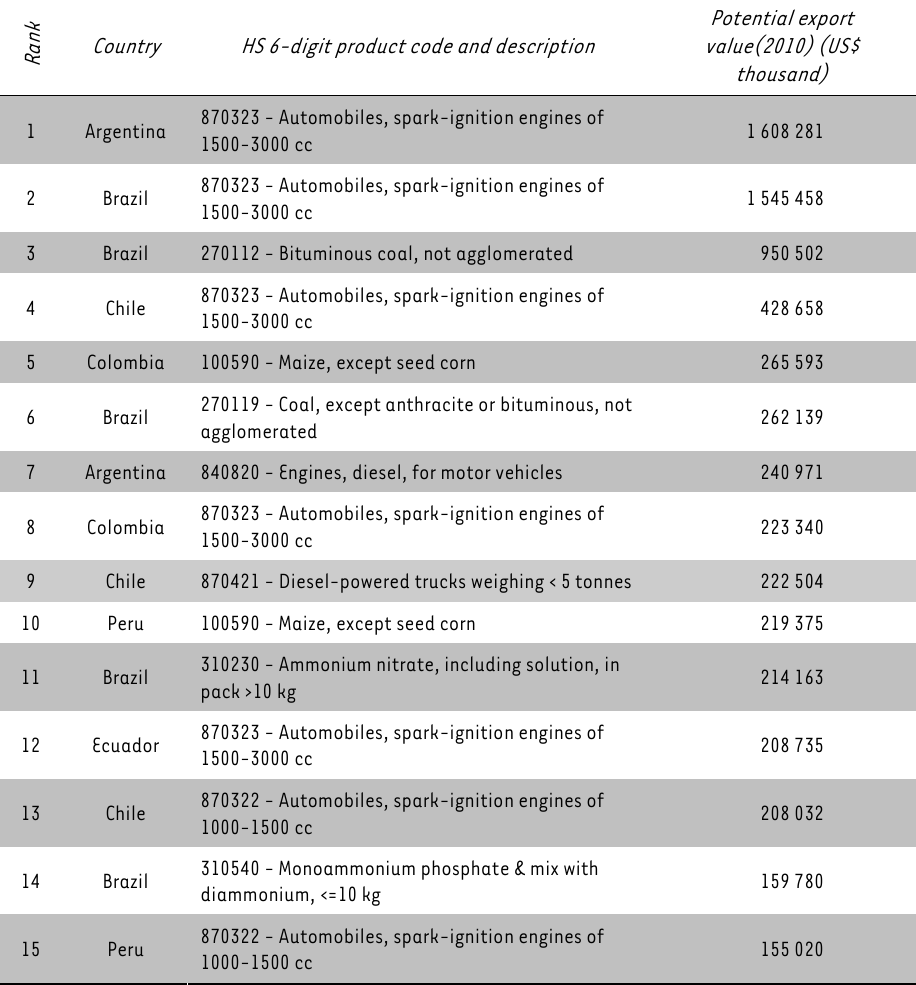
TABLE 11: Top 20 product-country combinations with the highest potential export value (US$ thousand) for South Africa in South America HS 6-digit product code and